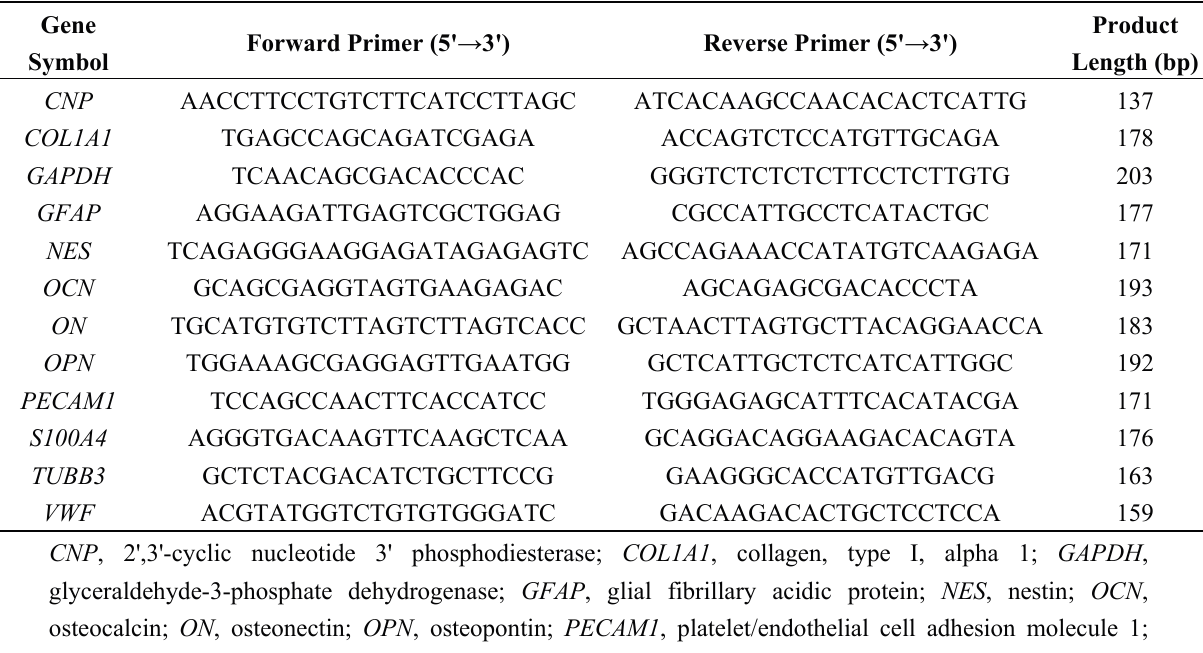
Table 1. Human primer sequences.